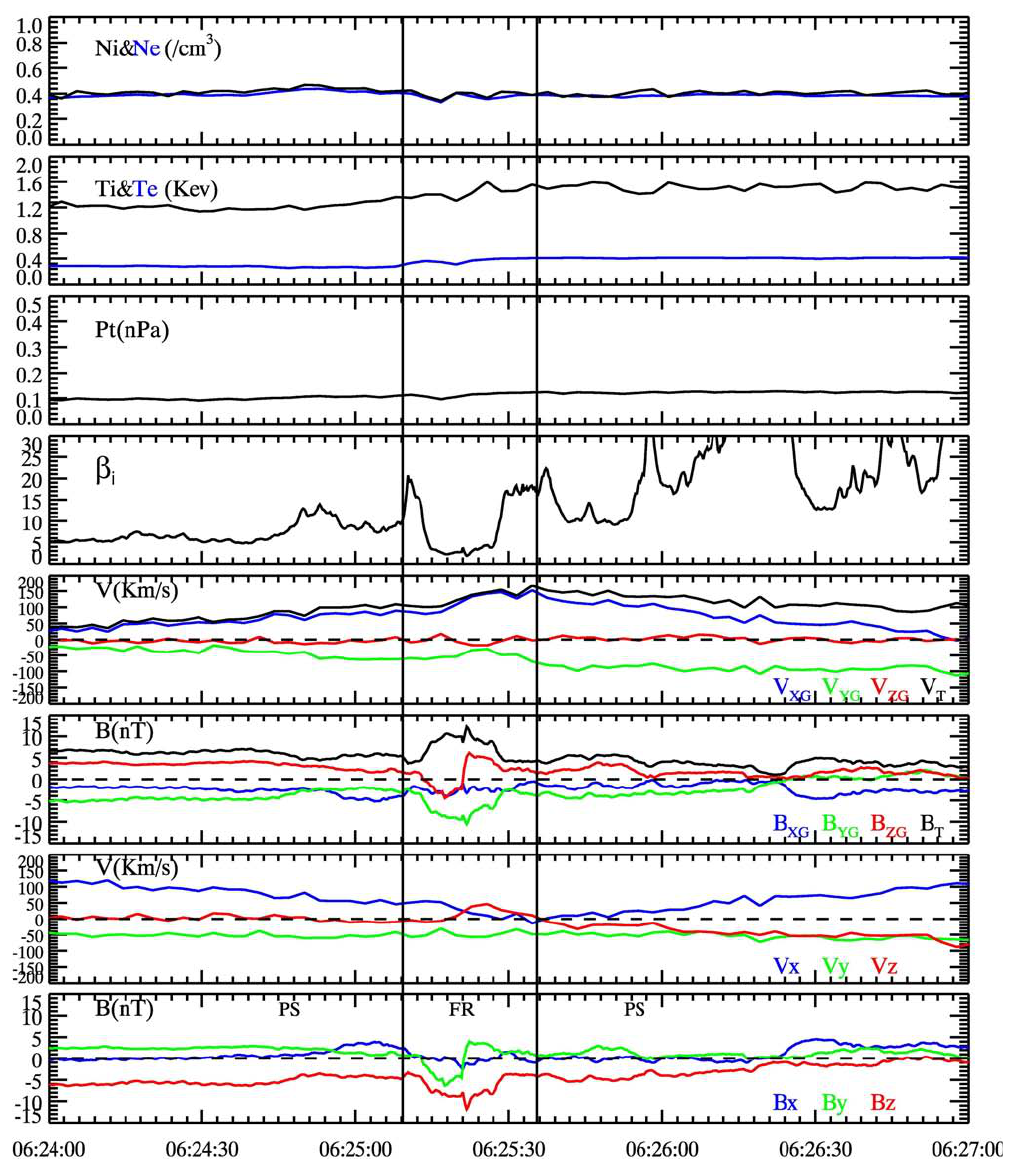
Fig. 1. THEMIS observation from 06:24UT to 06:27UT on 5 February 2009.